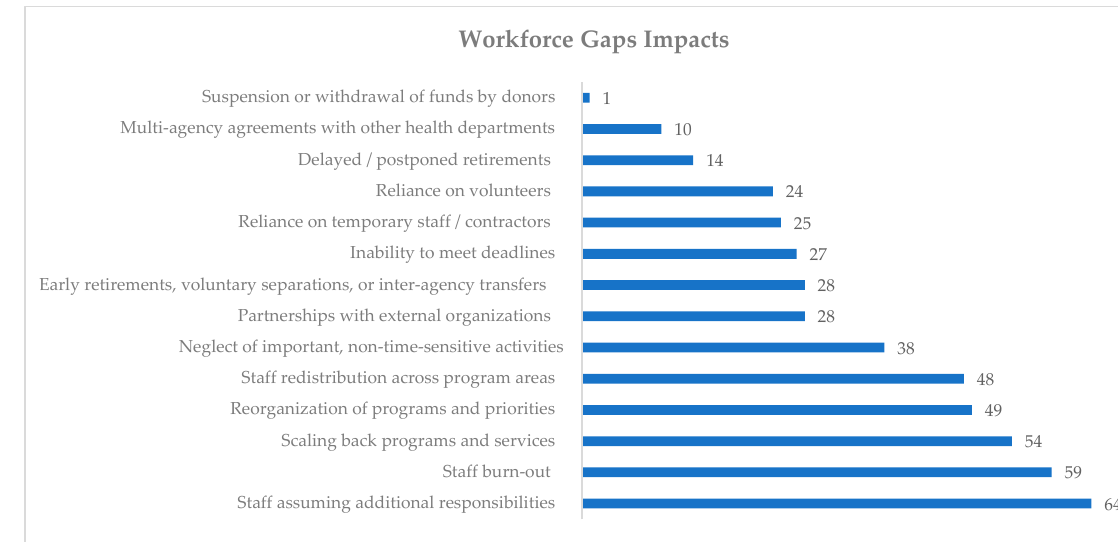
verse personnel impacts (theme 2.2). 44% of survey respondents ( n = 31) encountered other workforce gaps impacts. Within these themes, the top operational outcome from gaps was scaling back programs and services ( n = 54, 77%), and the top adverse personnel impact from gaps was staff burnout ( n = 59, 84%). The top other workforce gap impact was partnerships with the external organization ( n = 28, 40%). Table 3. Workforce gaps impacts experienced by survey respondents’ agencies sorted by focus group themes. ( n = 70). Workforce Gaps Impacts